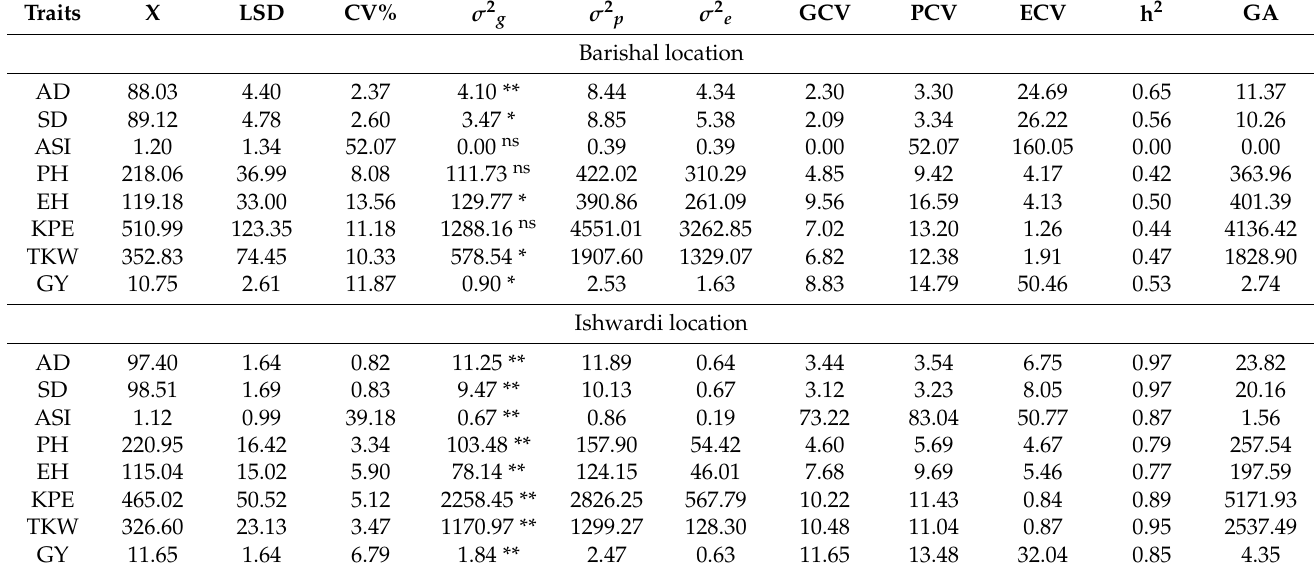
Table 1. Estimation of genetic parameters in eight traits of 45 genotypes of maize grown in multi- ple